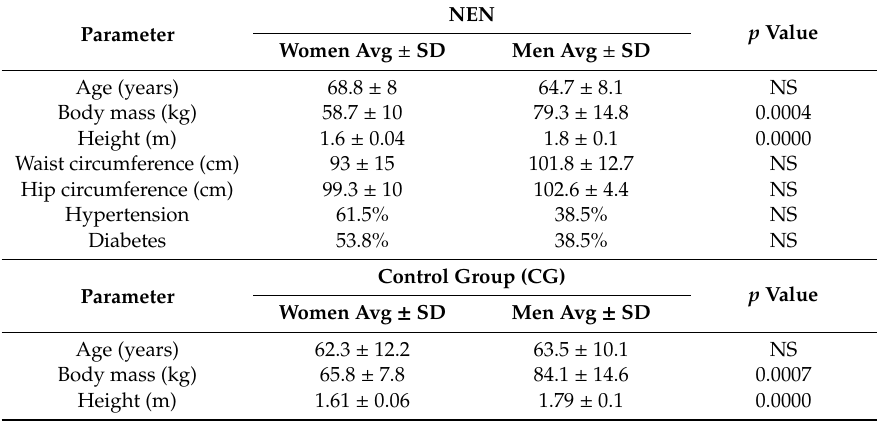
Table 1. The characteristics of the studied gastro-entero-pancreatic neuroendocrine tumors (GEP-NETs) patients (NEN) and control group